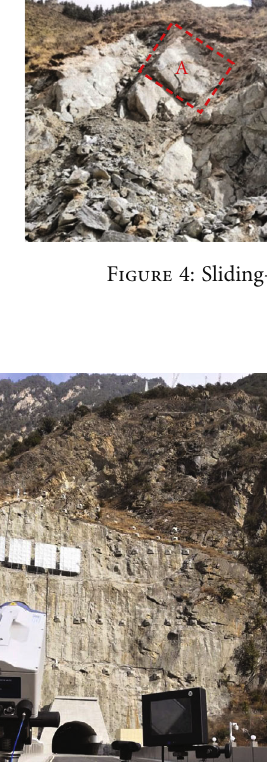
Figure 5: RSV-150 remote laser Figure 2.